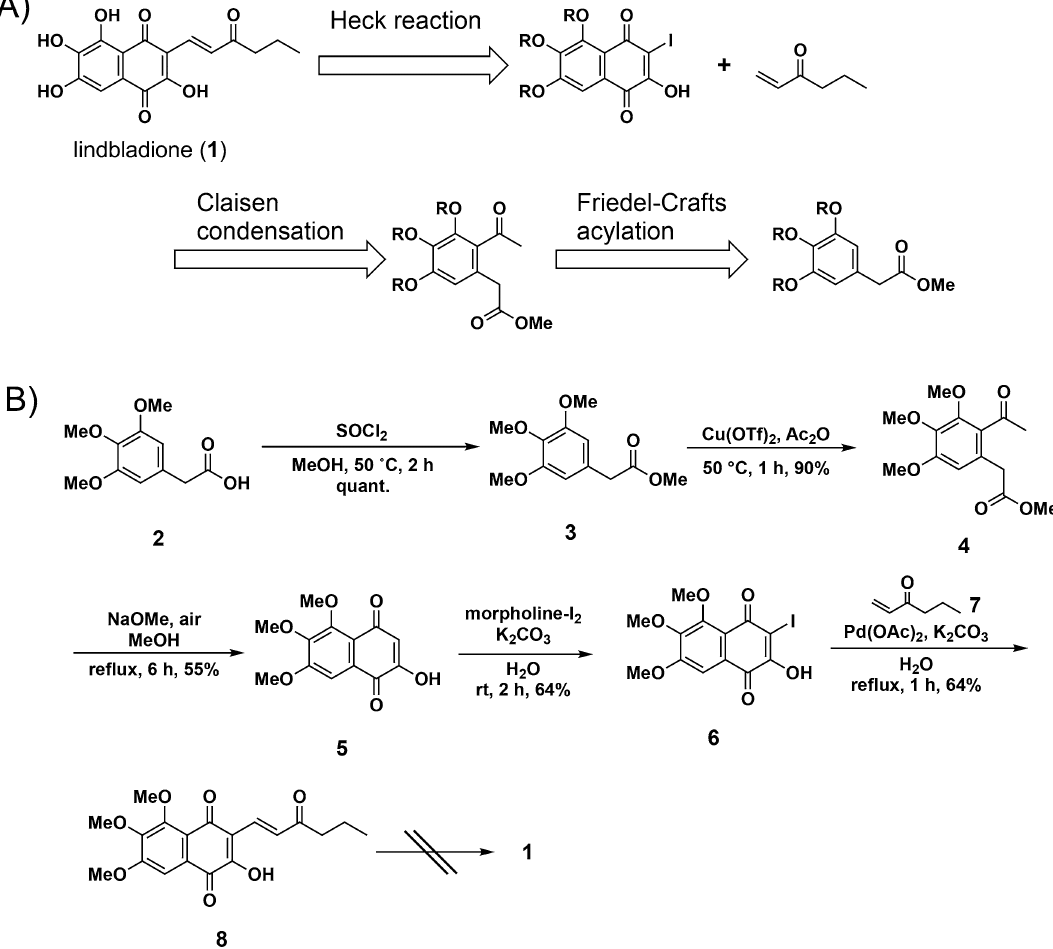
Figure 3. First trial of synthesis of 1 . ( A ) Retrosynthetic analysis of 1 . ( B ) Deprotection was a critical